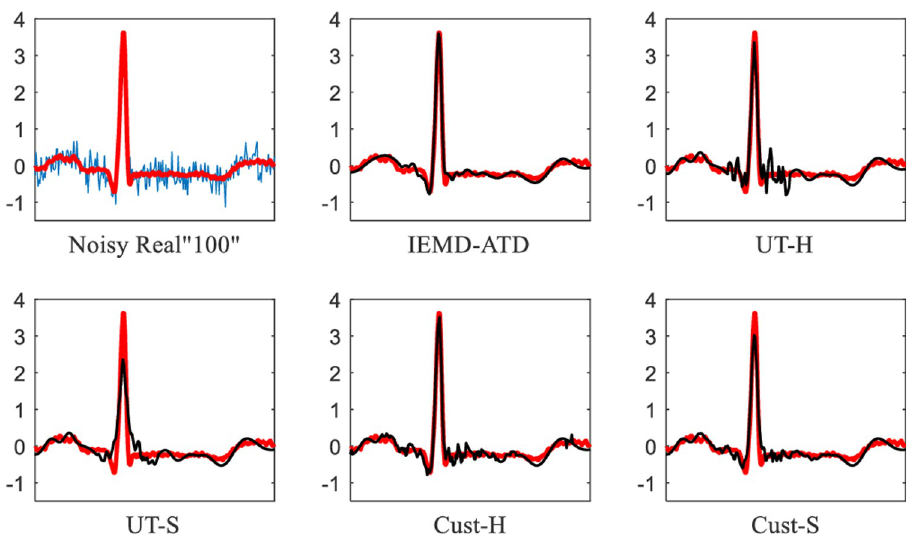
Fig 16. Details of waveforms between 6.2 and 6.85 seconds from Fig 15.